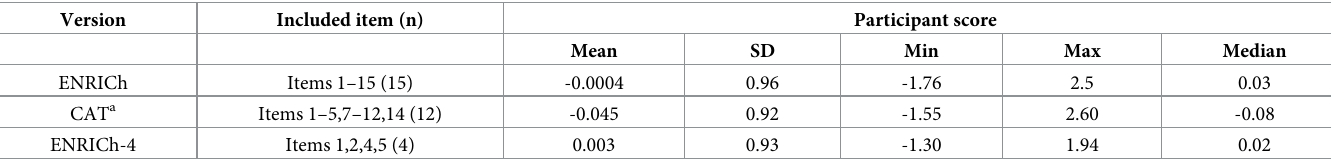
Table 7. Basic information of full ENRICh, CAT, and